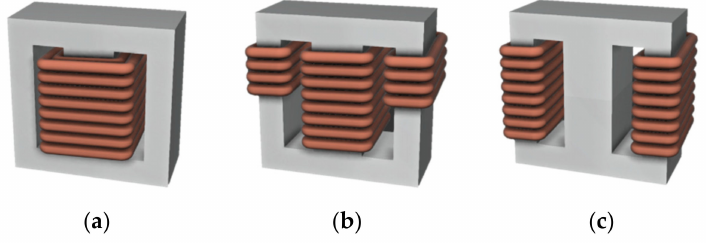
Figure 11. Secondary-side winding methods. ( a ) Winding only the center leg of the core. ( b ) Winding both the center leg and the outer legs of the core. ( c ) Winding only the outer legs of the